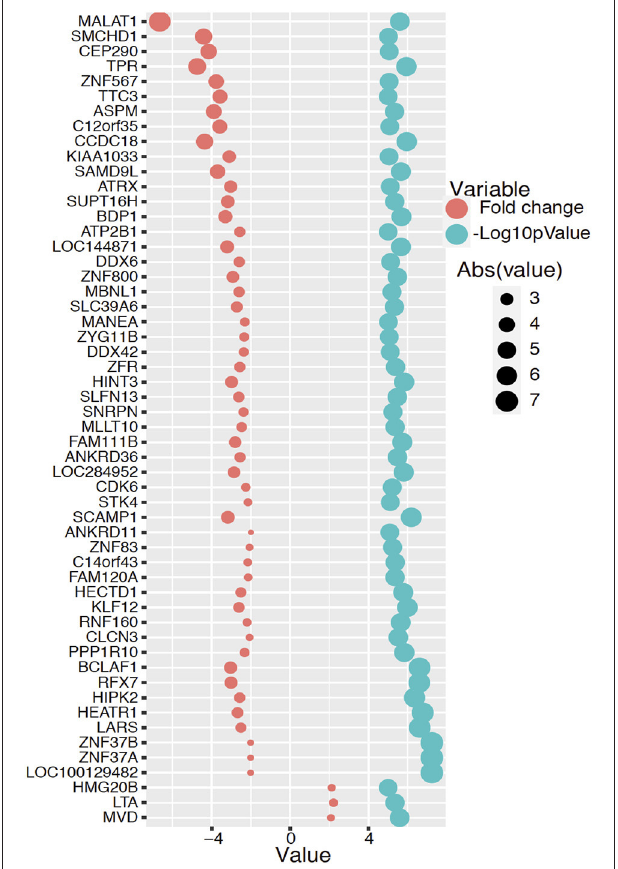
FIGURE 2 | Differentially expressed 54 genes with fold changes and –logarithmic 10 adjusted p -values. The red circle represents logarithmic fold change and the blue color circle represents –logarithmic 10 adjusted p -value for each significant gene.